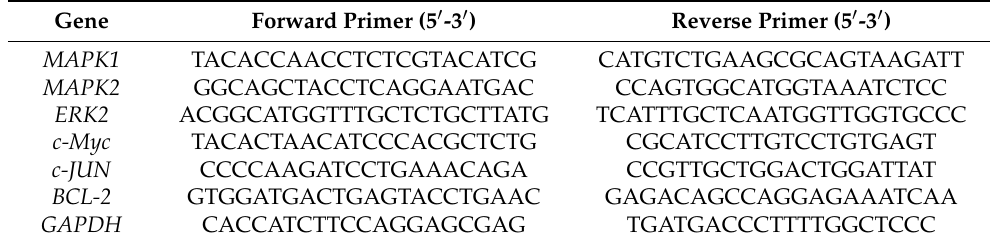
Table 1. RT-qPCR primers used in the